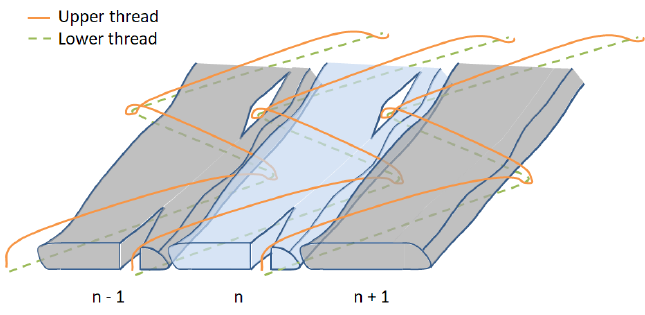
Figure 6. Scheme of the stitching (symmetric